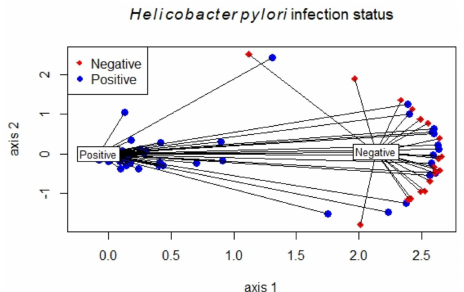
Figure 1. Nonmetric multidimensional scaling (NMDS) for microbial community composition based on Helicobacter pylori (HP) infection status.